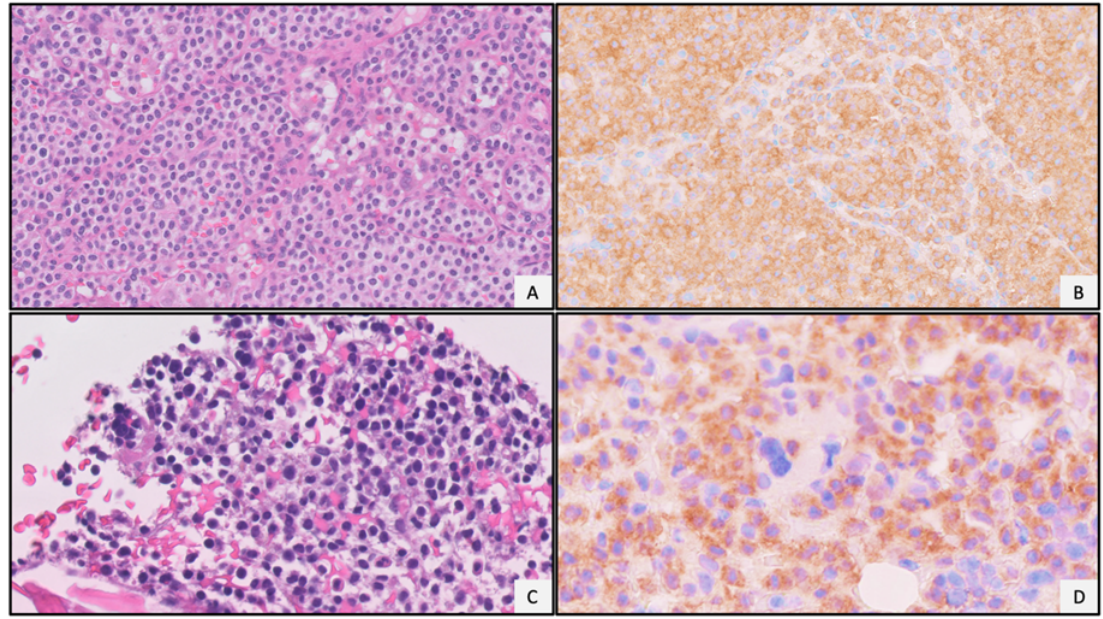
Figure 2. Examples of BRAF V600E point mutation specific antibody in a case of hairy cell leukemia. ( A ) Hematoxylin and eosin (H&E) stain of lymph node demonstrates diffuse monotonous proliferation of atypical lymphocytes with a characteristic “fried-egg” appearance, representing nodal involvement by hairy cell leukemia (magnification ×20). ( B ) BRAF V600E point mutation specific antibody shows diffuse cytoplasmic expression within the lymphomatous infiltrate (magnification ×20). ( C ) Atypical lymphomatous infiltrate within the bone marrow space (magnification ×20, H&E stain). ( D ) BRAF V600E immunohistochemical stain showing diffuse cytoplasmic expression within the atypical infiltrate representing hairy cell leukemia (magnification ×20). All images were taken using an Olympus BX50 microscope and a SPOT Insight 4 camera and SPOT 5.0 advanced software.